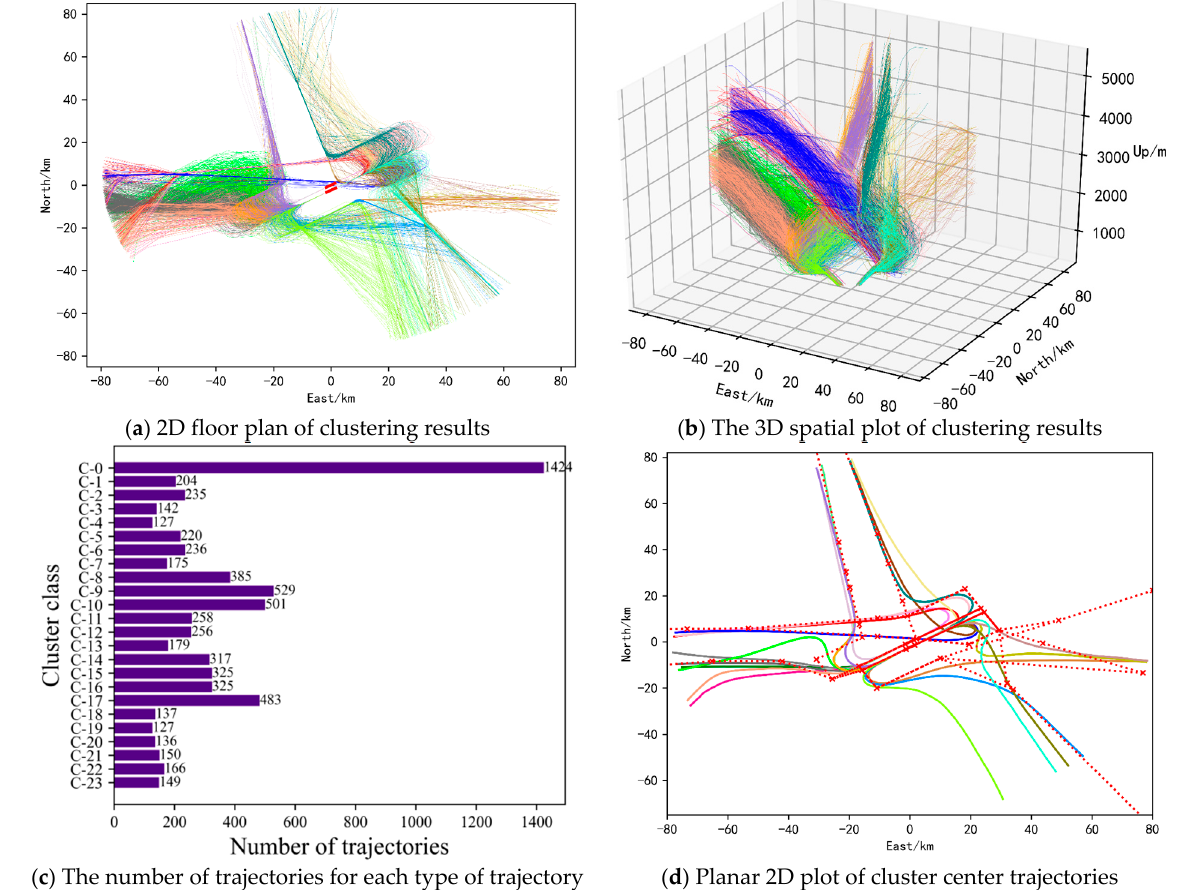
Figure 8. Clustering results of Landing trajectories.